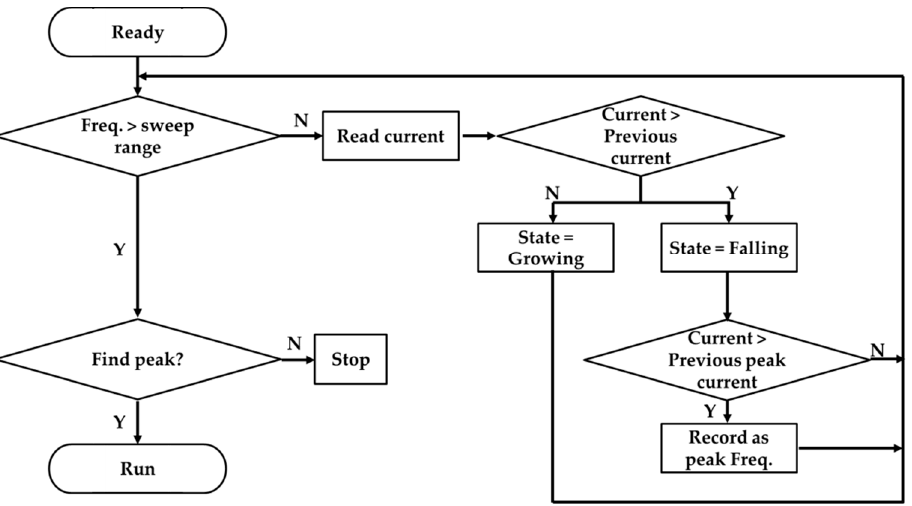
Figure 3. Automatic resonance frequency tuning algorithm [21].